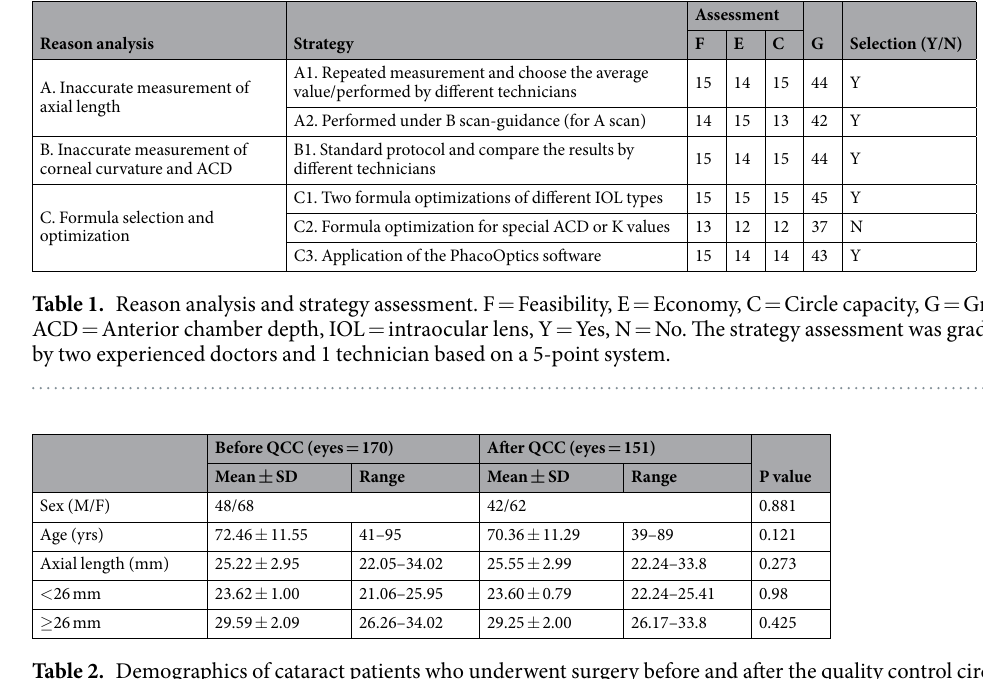
Table 2. Demographics of cataract patients who underwent surgery before and after the quality control circle activity. QCC = Quality control circle, SD = Standard deviation, F = Female, M =